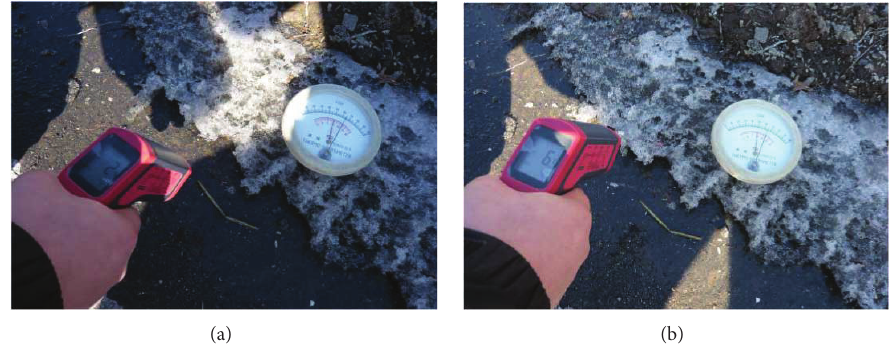
Figure 10: Temperature testing of the pavement outside the tunnel.